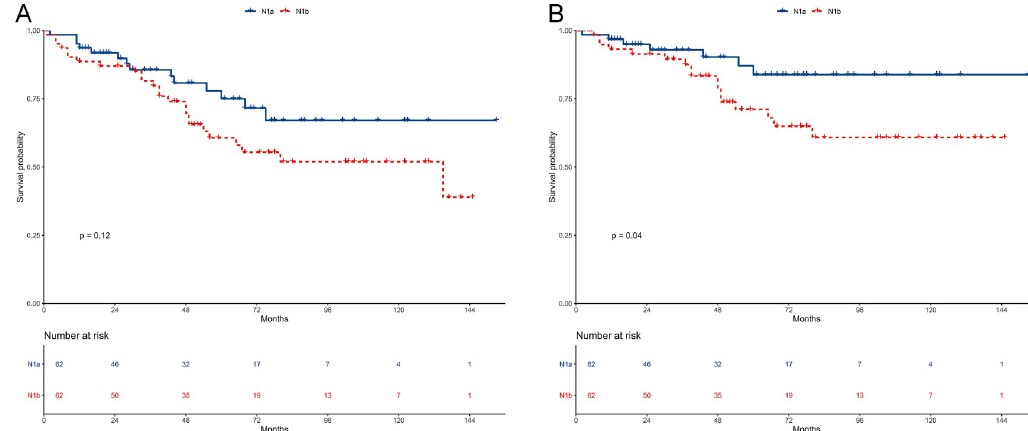
https://doi.org/10.1371/journal.pone.0253424.g004